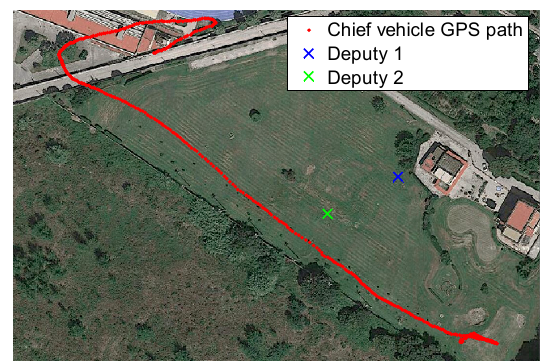
Figure 11. Formation geometry Test 2.